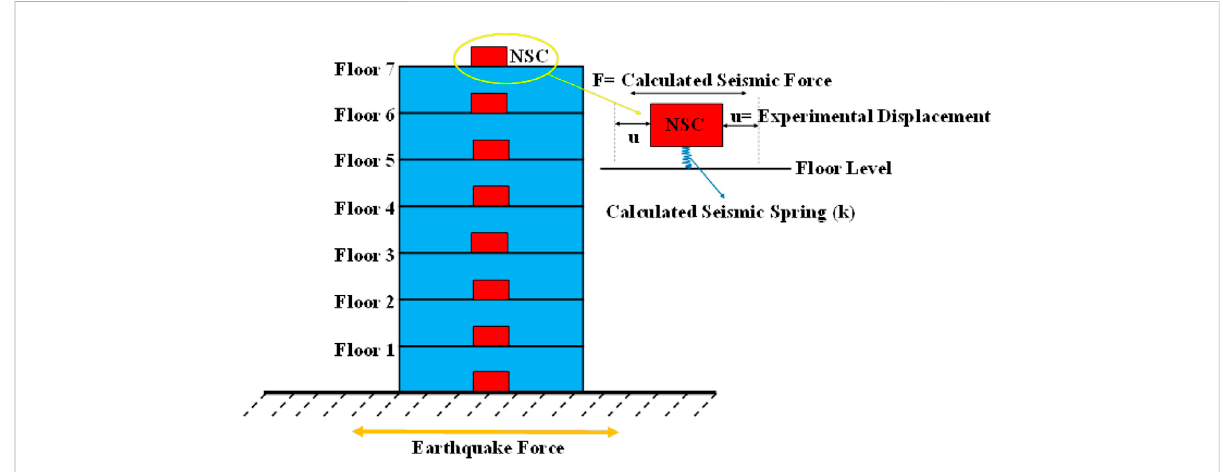
Placing spring elements of NEs to the library structure (Cavuslu,